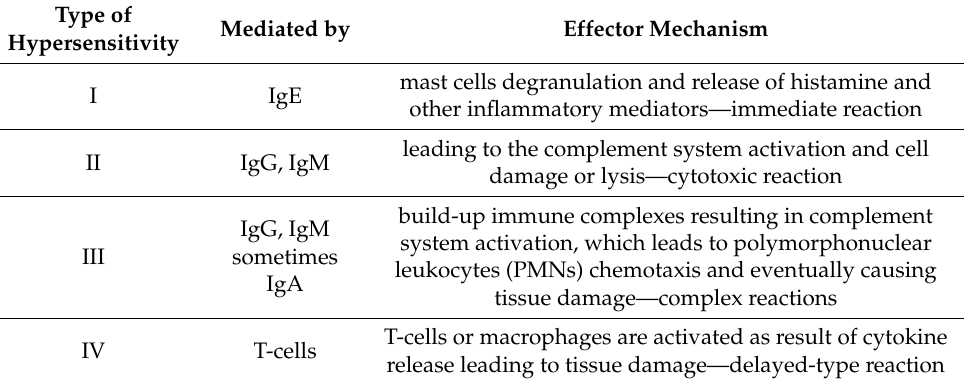
Table 1. Classical Gel Combs classification of hypersensitive